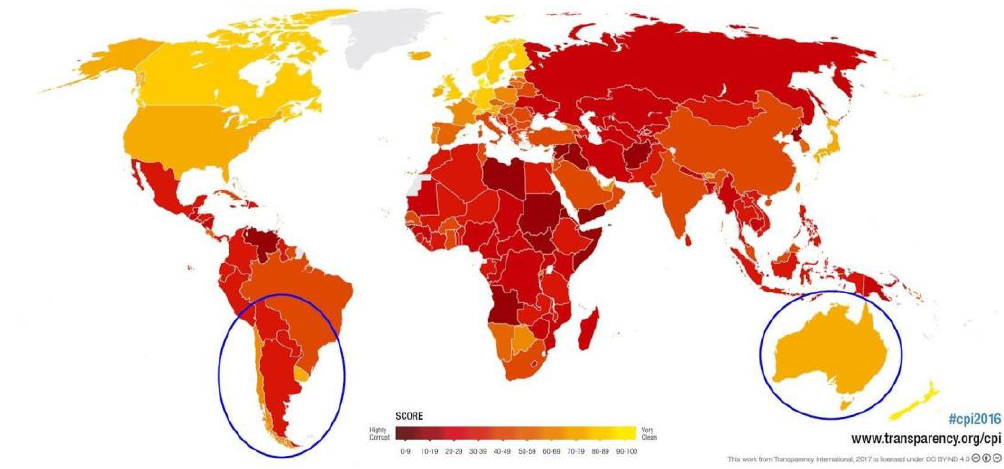
Figure 3: Corruption Perceptions Index